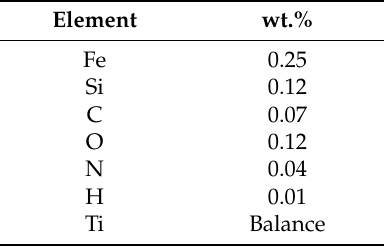
Table 1. Elemental composition of the VT1-0 commercially pure